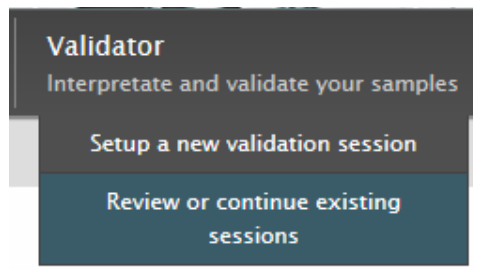
Figure 8. Setting up a randomly selected validation